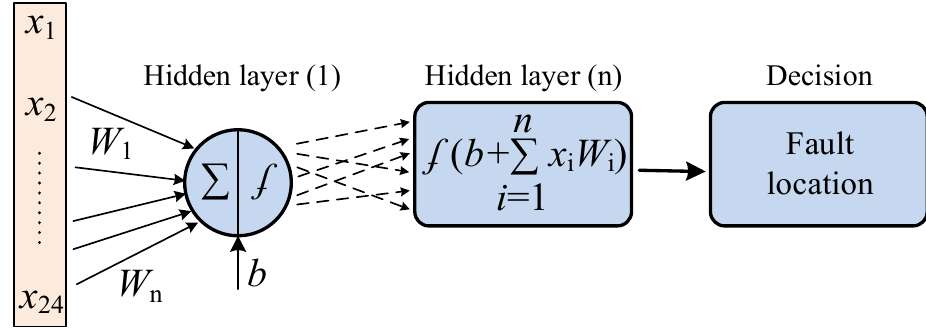
Figure 2. Structure of the ANN for fault location scheme.